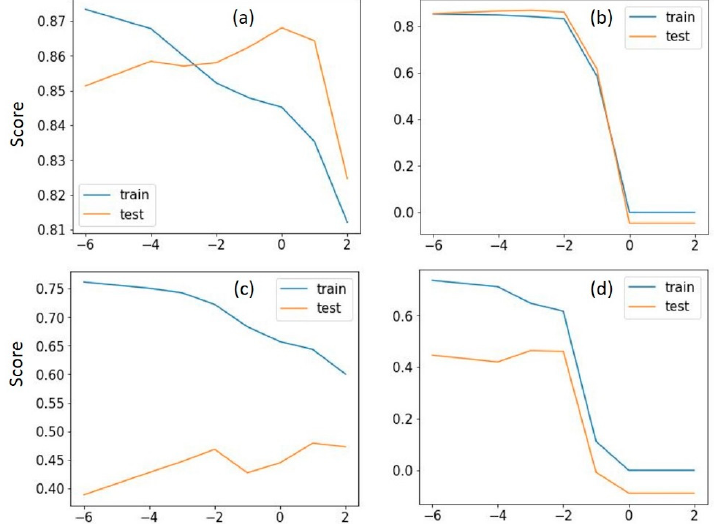
Figure A2. Train and test scores of the Ridge ( a , c ) and LASSO ( b , d ) ML regressors for the barley ( a , b ) and wheat ( c , d ) datasets. The alpha ranges used were 0.000001, 0.0001, 0.001, 0.01, 0.1, 0, 1, and 100.